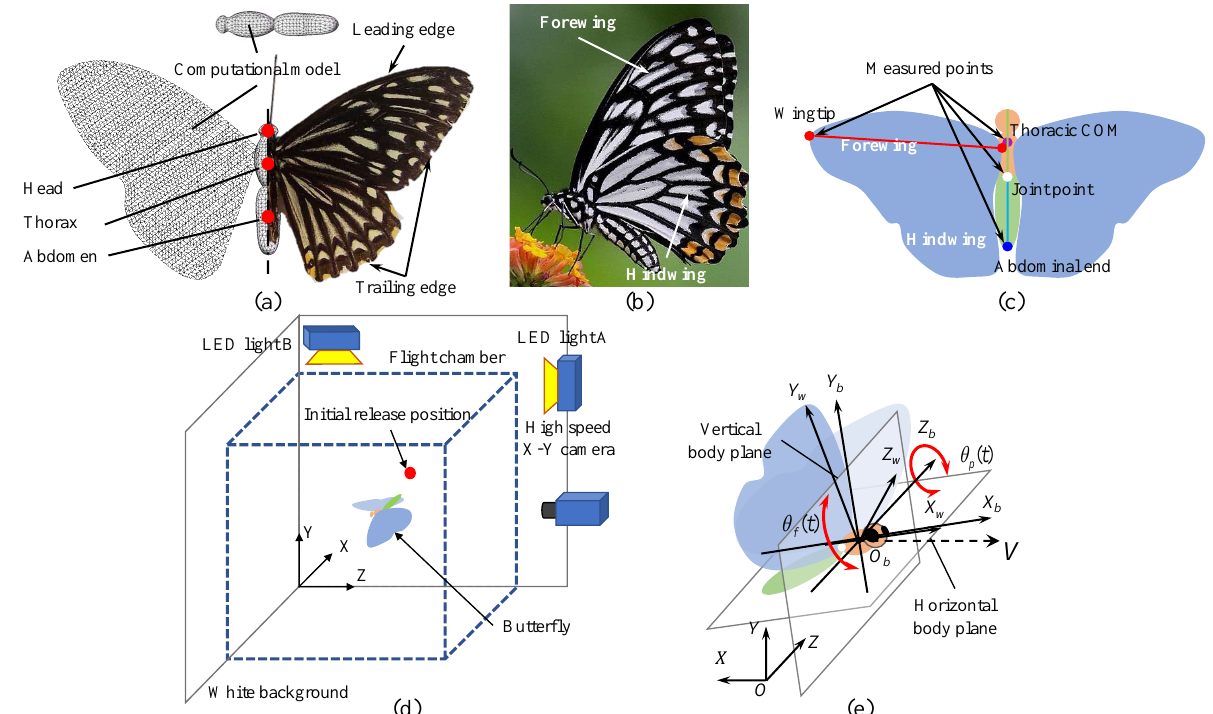
Figure 1. Observation experiment for butterfly flight based on high-speed camera: ( a ) geometry of a Chilasa clytia and the computational model with mesh, butterfly body mesh model; ( b ) live butterfly with the forewing (FW) and hindwing (HW) in natural environment; ( c ) schematic diagram of butterfly observation feature points and body kinematic parameters; ( d ) experiment system; and ( e ) three coordinate systems to describe the motion of a butterfly, namely the inertial coordinate system ( X , Y , Z ) , the body-fixed coordinate system ( X b , Y b , Z b ) and wing-fixed coordinate system ( X w , Y w , Z w )